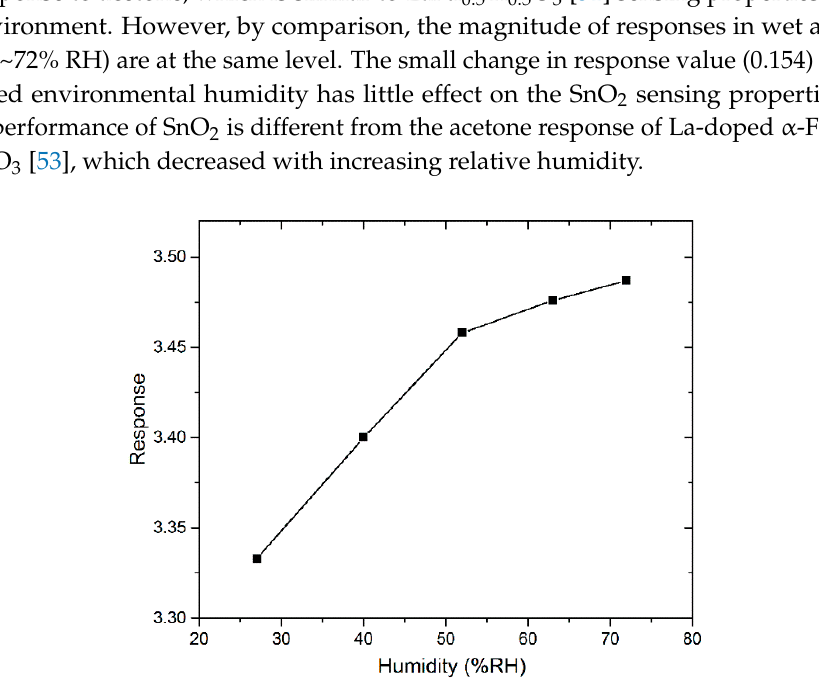
Figure 10. The humidity dependence of the sensing response to 1 ppm acetone at the operating temperature of 180 °C for SnO 2 annealed at 600 °C.